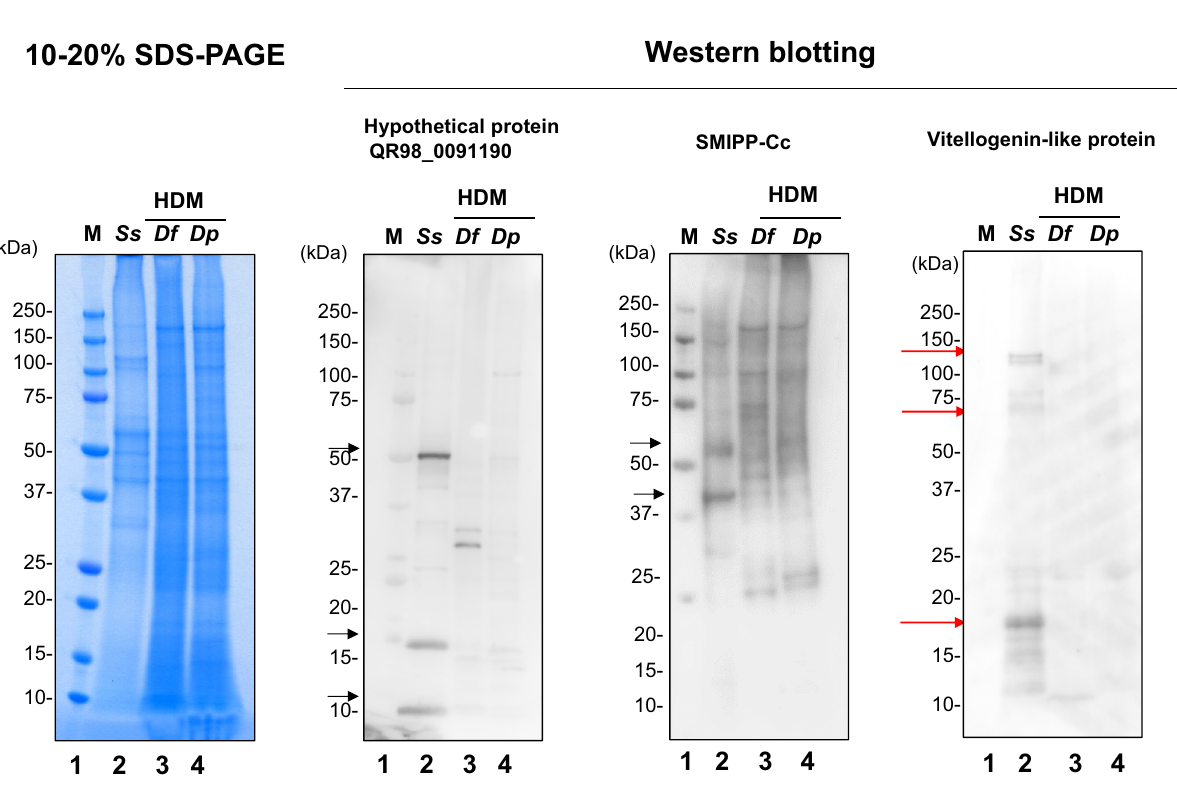
Figure 4. Western blot analysis of the three target antigens for S. scabies diagnosis. The whole mite lysates (20 μg/lane) of S. scabies and HDMs ( D. farina, D. pteronyssinus ) were immunoblotted with preparations of anti- hypothetical protein QR98_0091190, SMIPP-Cc, and vitellogenin-like protein rabbit polyclonal antibody. Lane 1, molecular weight marker; Lane 2, whole lysate of S. scabies ( Ss ); Lane 3, whole lysate of D. farina ( Df ); Lane 4, whole lysate of D. pteronyssinus ( Dp ); The red arrows indicate the specific bands (17, 70, and 150 kDa) exhibiting reaction to the anti-vitellogenin-like protein antibody. The black arrows indicate the three clear bands (50, 17, and 10 kDa) in the experiment in which the anti-hypothetical protein QR98_0091190 antibody was used and the two bands (40 and 60 kDa) detected using the anti-SMIPP-Cc antibody. These photo data were taken at the same exposure time (4.7